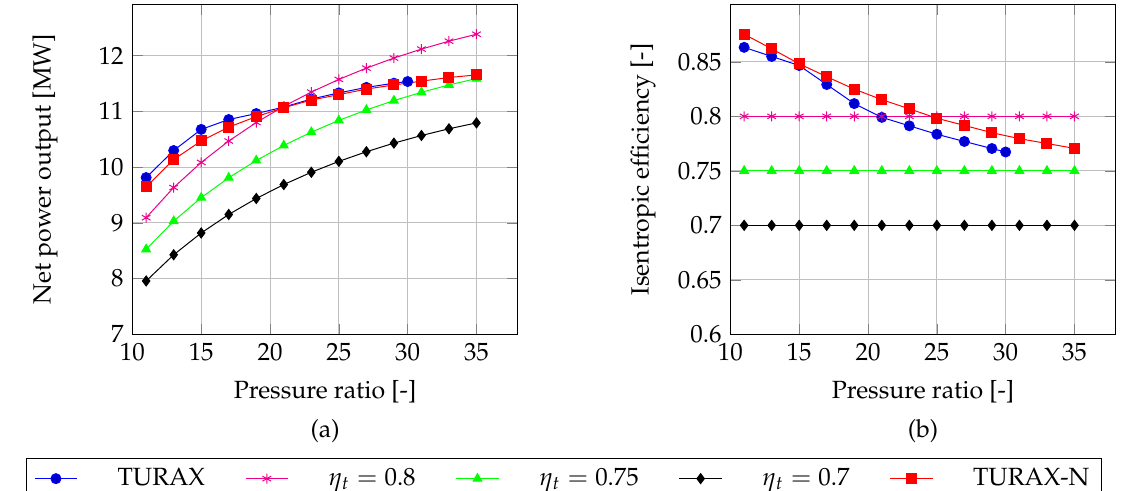
Figure 17. Multiple exhaust gas configuration. ( a ) net power output versus pressure ratio and ( b ) total-to-total turbine isentropic efficiency versus pressure